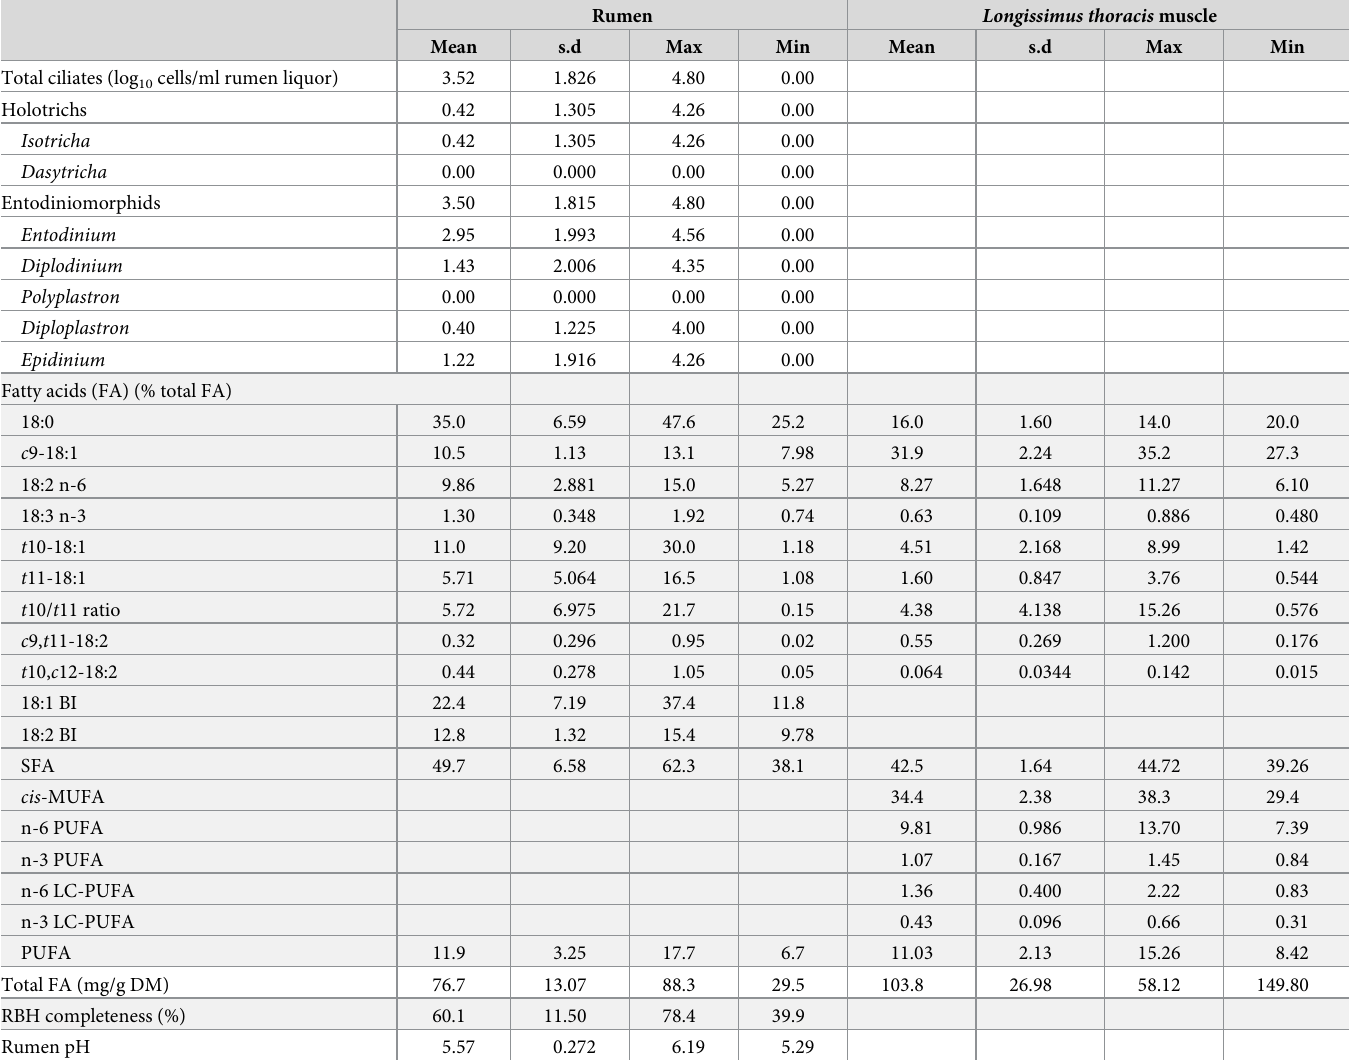
Table 2. Mean, standard deviation, minimum and maximum values for the phenotypes identified in Experiment